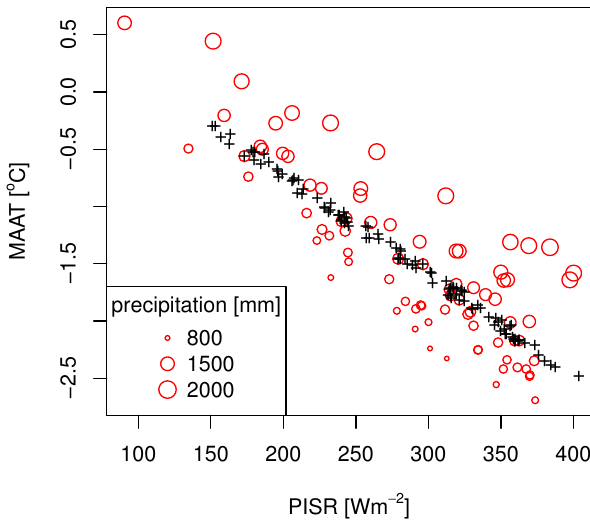
Fig. 7. Prediction values for the two first models from Table 3 calcu- lated for a randomly selected probability range of 0 . 475–0 . 525 for intact rock glacier occurrence. Black crosses: debris model with- out cPRECIP as explanatory variable, red bubbles: debris model including cPRECIP as explanatory variable.